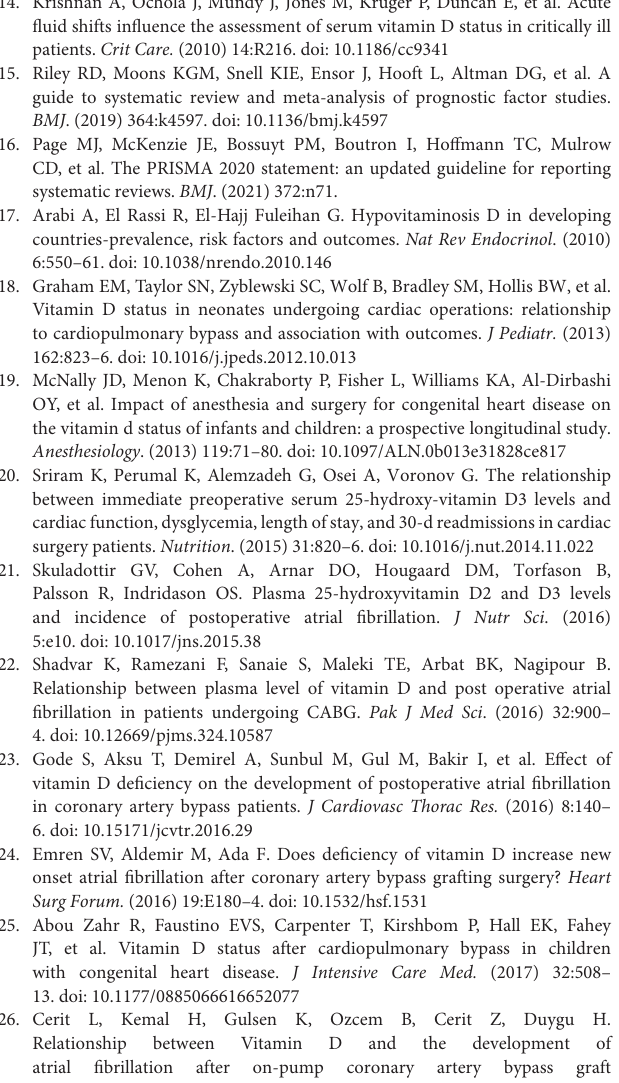
Supplementary Figure 1 | Egger’s publication bias plots for the assessment of potential publication bias. Each dot represents each study in the meta-analysis. (A) For the VitD level preoperative and immediate post cardiac surgery, and the Egger’s plot did not show significant asymmetry ( P = 0.713, t = 0.39, 95%CI ( − 15.13, 20.14), (B) for the VitD level preoperative and 24-h post cardiac surgery, the Egger’s plot did not show marked asymmetry, P = 0.849, t = 0.2, 95%CI ( − 10.37, 12.21), (C) for the RRs of VitD deficiency rate of pre- and 24-h post-cardiac surgery, the Egger’s plot did not show significant asymmetry,